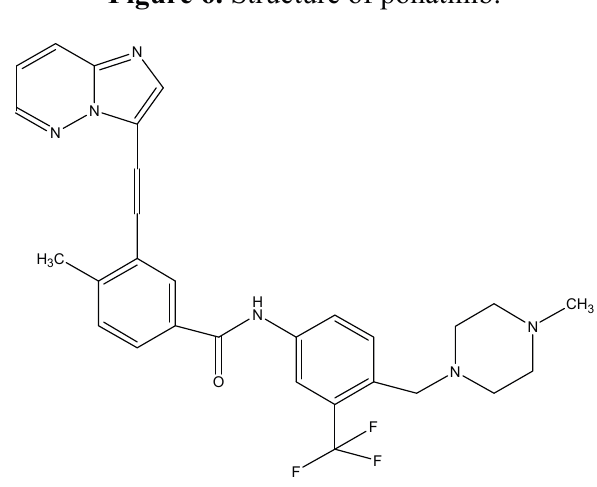
Figure 6. Structure of ponatinib.